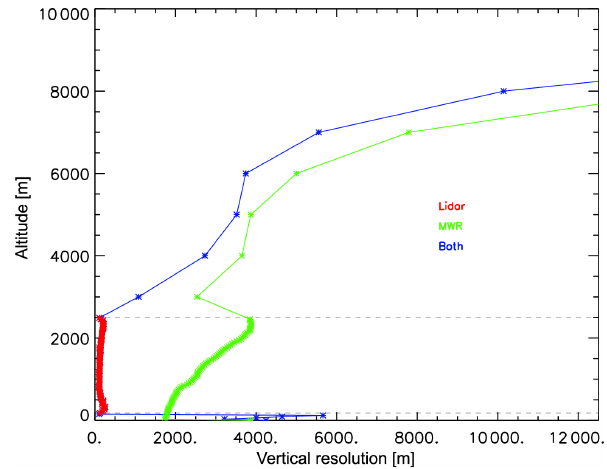
Figure 3. Vertical resolution for the only-RL (red), only-MWR (green) and MWR+RL (blue). The dashed lines enclose the area where RL data have been